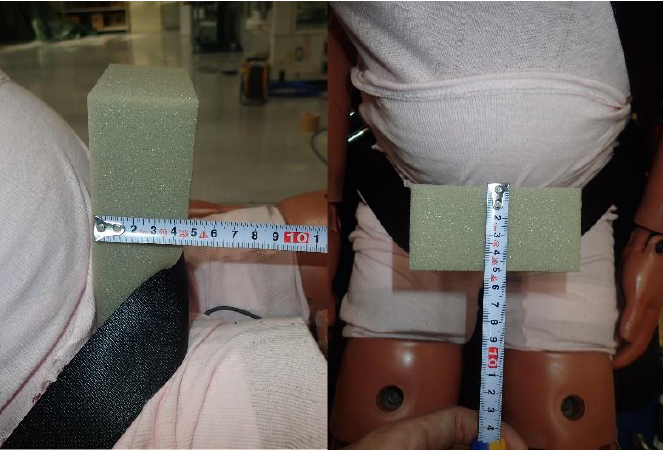
Figure 2. Test setup of the MAMA-2B dummy with a sponge inserted between the lower abdomen and lap belt, so that the lap belt passes across the left and right thighs.